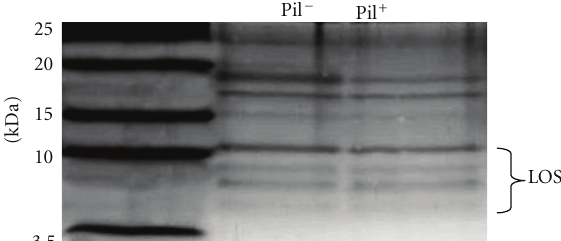
Figure 3: Lipooligosaccharide profiles of NGO strains used in this study. Whole-cell lysates of gonococcal strains were treated with proteinase K overnight and then boiled prior to Tricine SDS-PAGE (16%). Protein molecular weight marker: Novex Sharp Standard